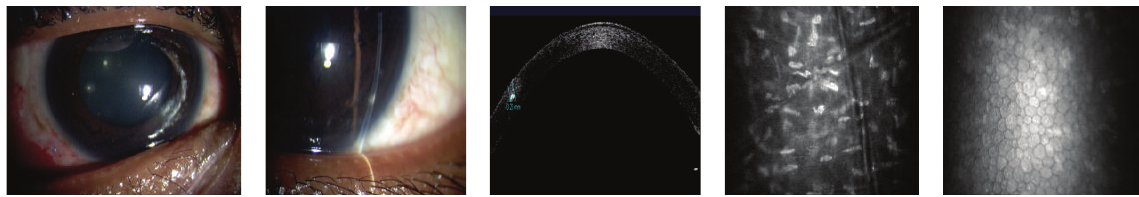
Figure 2: Slit lamp photographs of corneal foreign bodies and corresponding corneal AS-OCT and CM images of the stroma and endothelium.